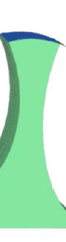
Figure 3. Simulation of the lining using plate elements.